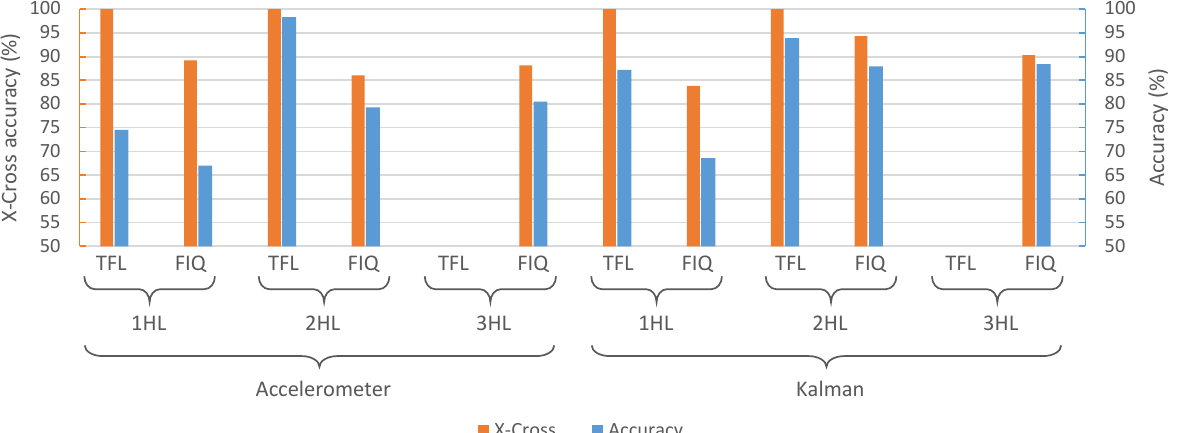
Figure 4. X-cross accuracy and accuracy of the different ANN models deployed on the different hardware platforms presented in Section 2.6. Since these results are hardware-independent, no distinction between them is made. TFL stands for TensorFlow Lite, while FIQ refers to Full Integer